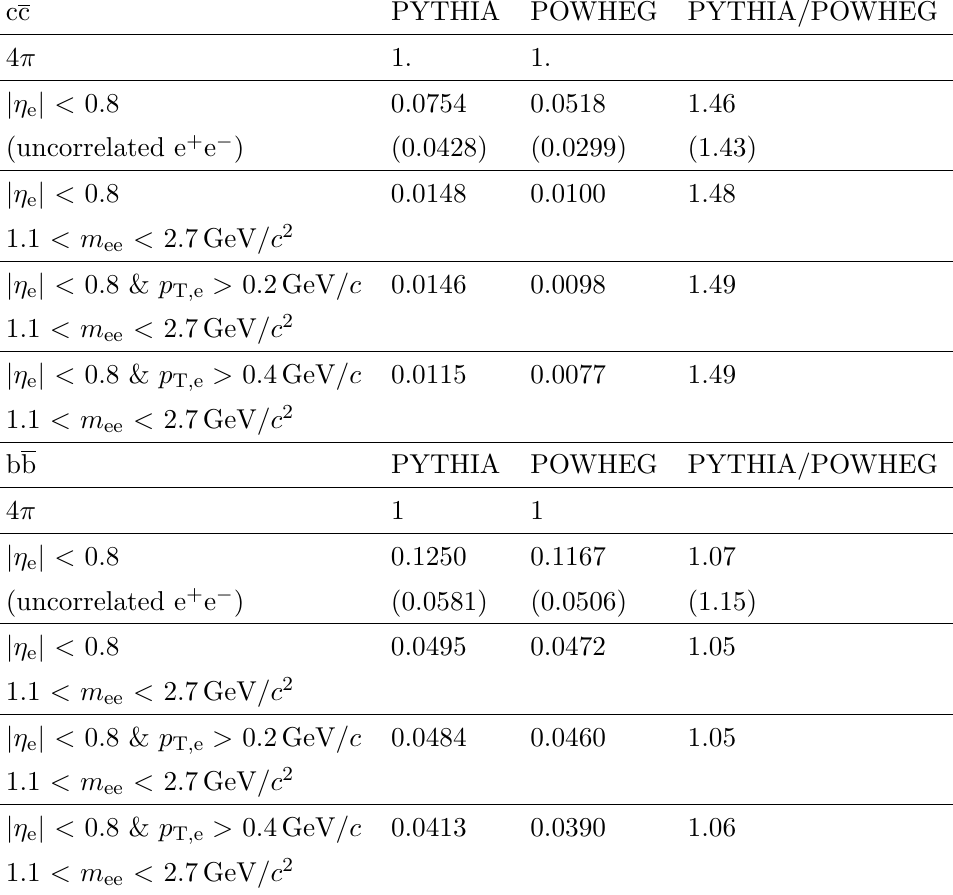
Table 3 . Fraction of correlated e + e (cid:0) pairs in 4 (cid:25) and after consecutive acceptance selection criteria (left column) for two di(cid:11)erent event generators (PYTHIA/POWHEG) and their relative di(cid:11)erence (right